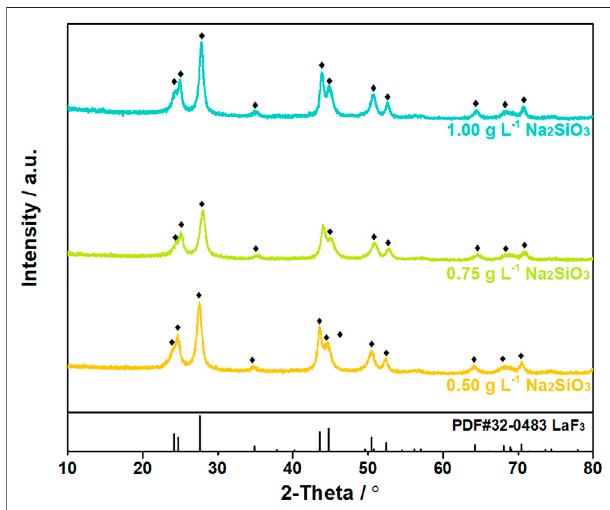
FIGURE 8 | XRD patterns of fi ltration residues obtained from solutions with La/F molar ratio of 1:3.00 after 1 h reaction in the presence of different doses of Na 2 SiO 3 .